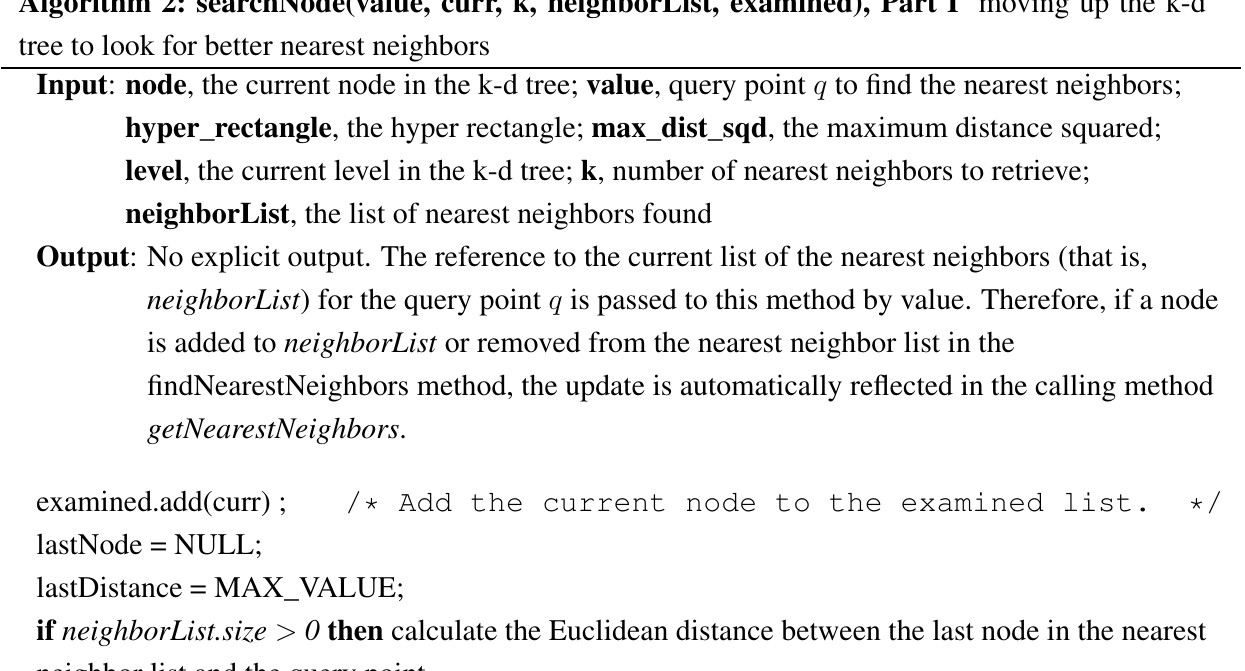
Algorithm 2: searchNode(value, curr, k, neighborList, examined), Part I moving up the k-d tree to look for better nearest